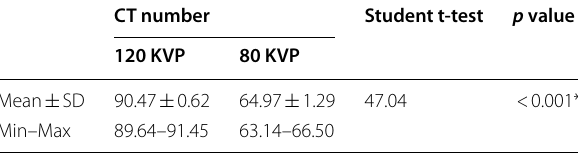
Table 3 Comparison of CT number between 120 and 80